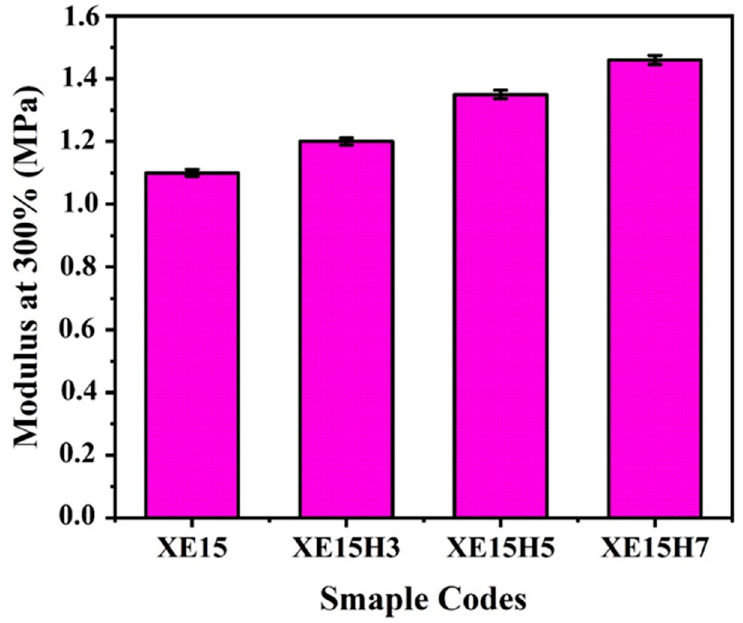
Figure 5. Elongation at break of various XNBR/epoxy/XHNTs nanocomposites.